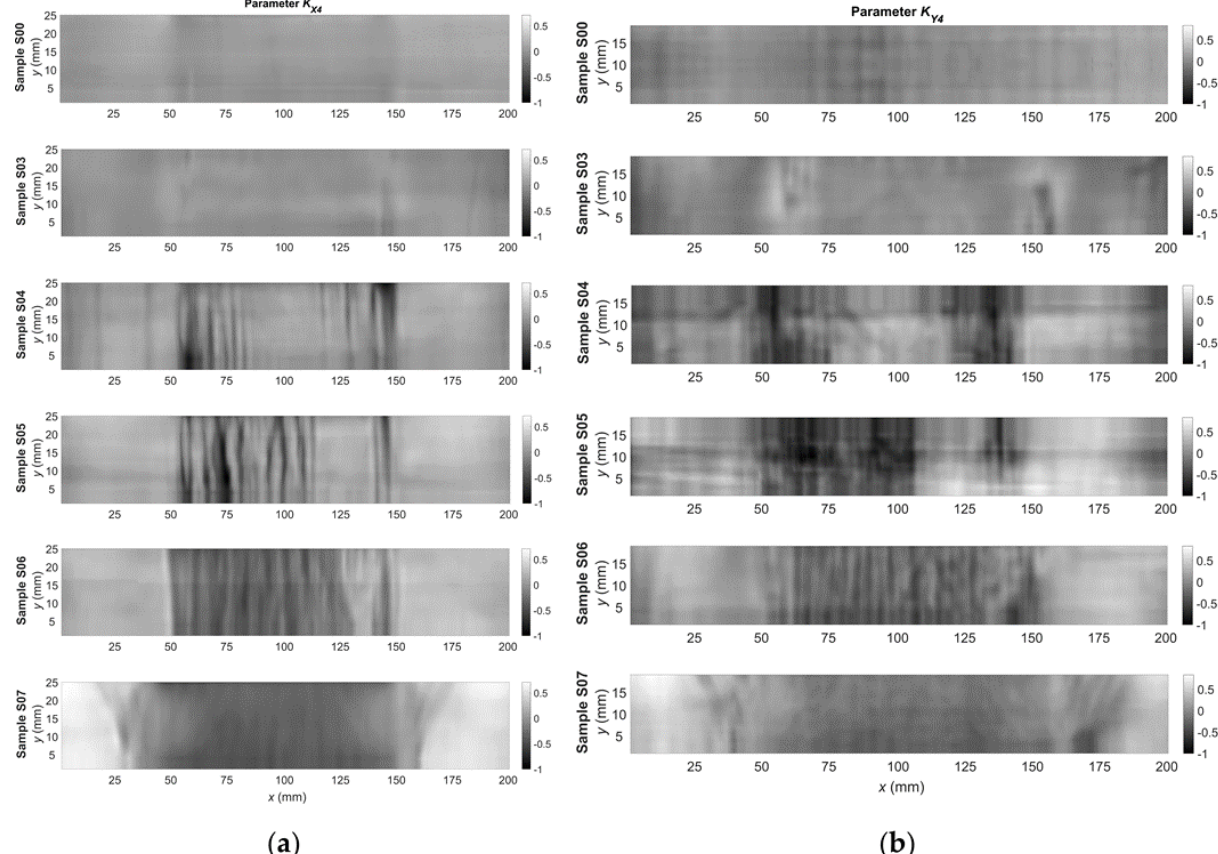
Figure 6. Relative change in the K A 4 parameter as a function of the coordinates of the point from the measurement area for the: ( a ) x -axis direction; and ( b ) y -axis direction.